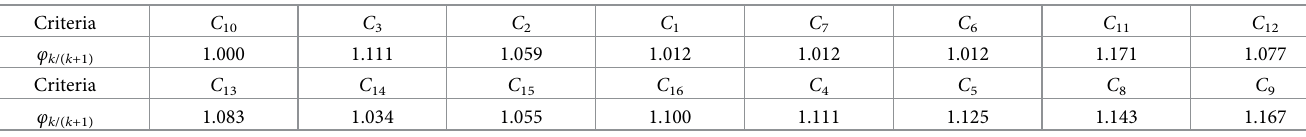
Table 7. Vector of the comparative priorities of the evaluation criteria.